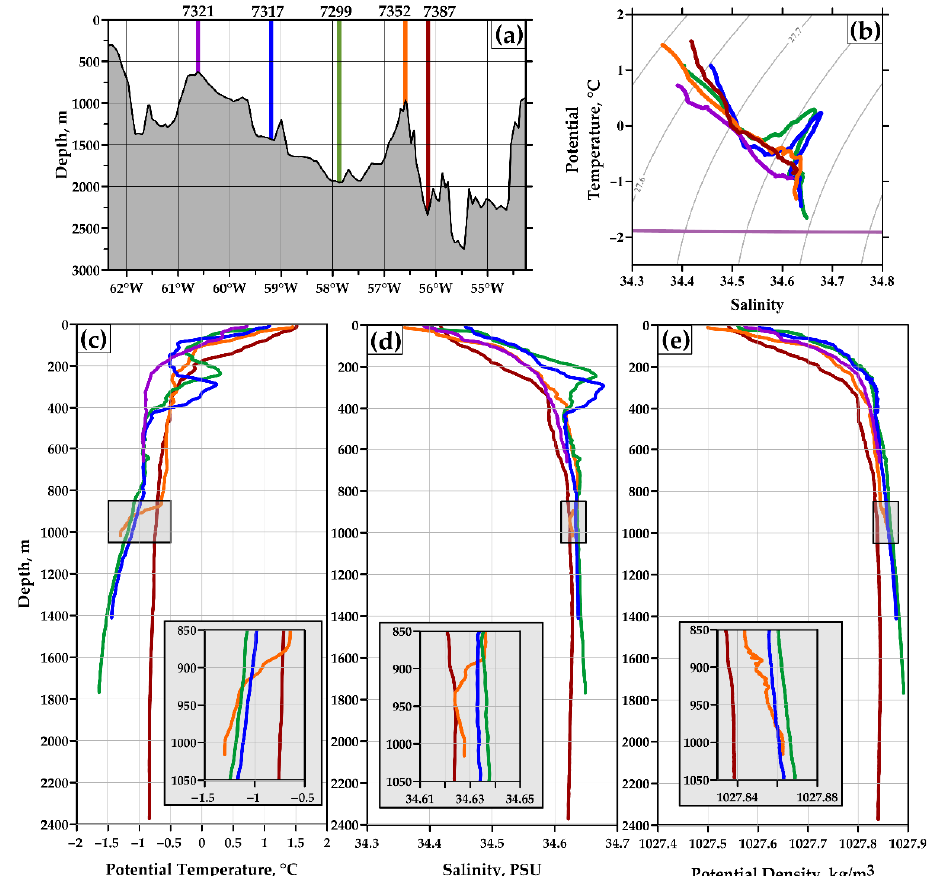
Figure 10. Potential temperature, salinity, and potential density along the thalweg of the BS: ( a ) location of stations relative to the basins of the strait, ( b ) temperature-salinity diagram, ( c ) profiles of potential temperature, ( d ) salinity, and ( e ) potential density. The colors of stations are the same in all panels. All profiles at depths of the overflow (850–1050 m) are shown in the insets in more detail.